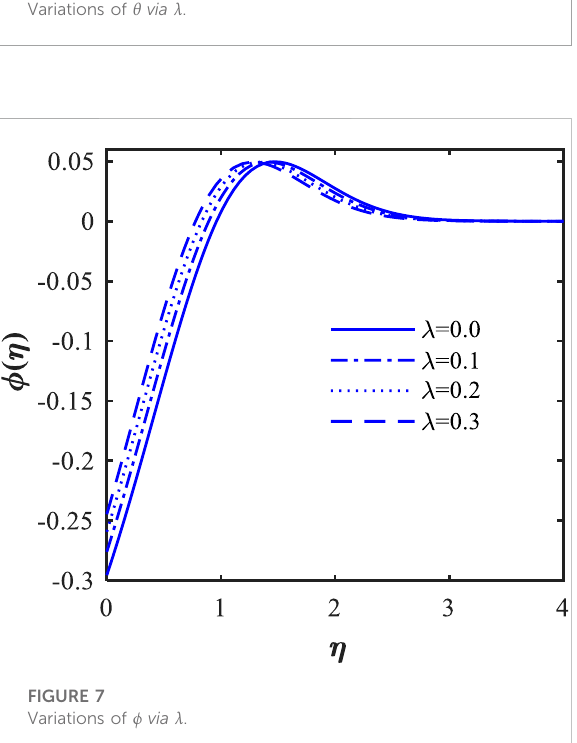
FIGURE 6 Variations of θ via λ .